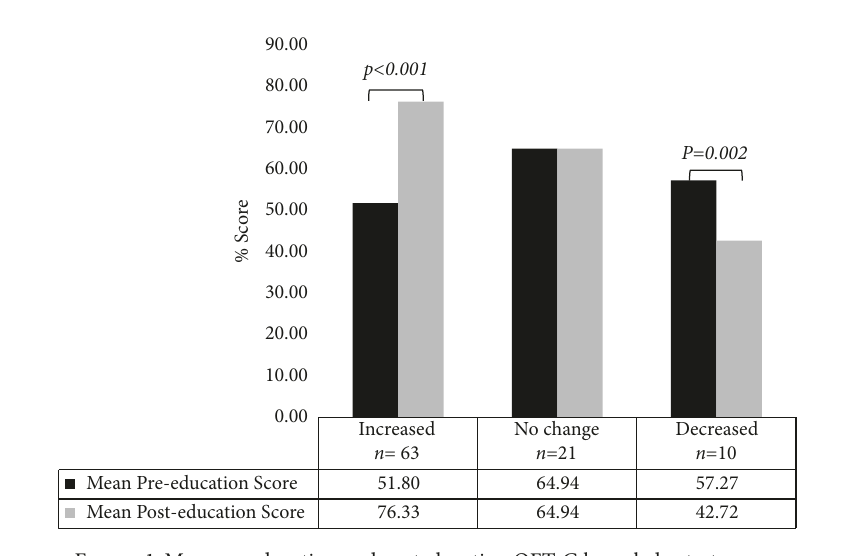
Figure 1: Mean preeducation and posteducation QFT-G knowledge test